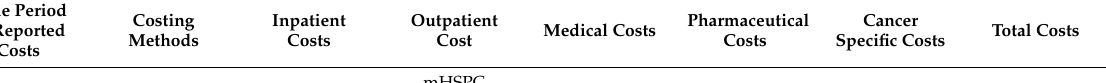
Table 3. Costs, ICERs, and probability of cost effectiveness for CEA in mHSPC and